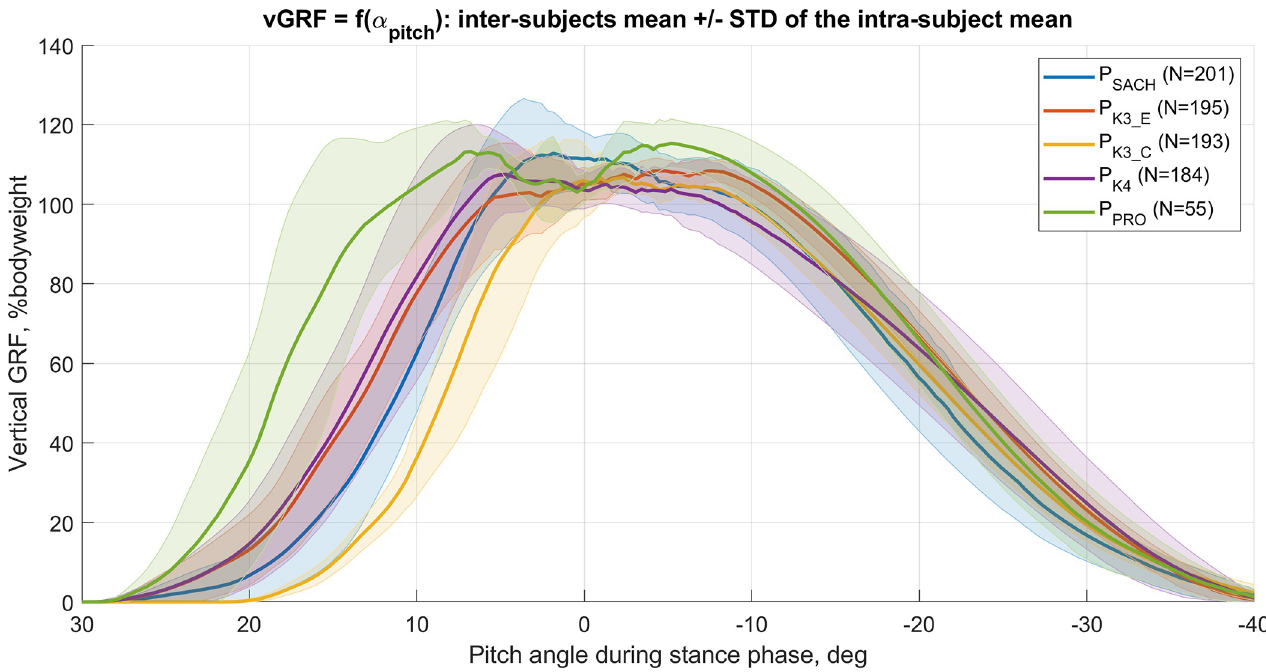
Fig 6. Normalized vertical GRF as a function of α pitch during within stance phase for five feet. Each solid thick line corresponds to the mean values over all subjects, while the standard deviations are shown with shaded areas. The steps from 13 subjects were used to calculate P SACH , P K3_C , P K3_E , and P K4 statistics, while 5 subjects were used for P PRO (i.e., 5 among the 13 participants have tested P PRO ).